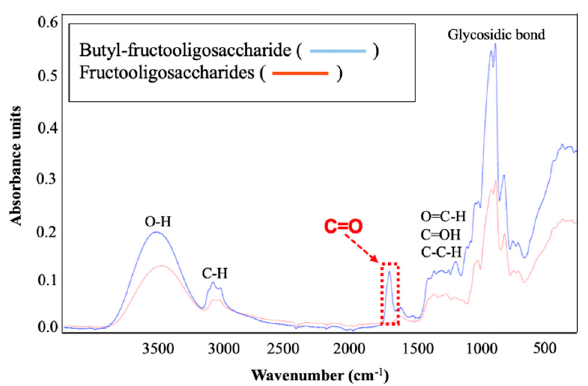
Figure 1. Absorbance spectra of butyl-fructooligosaccharides (B-FOS) and FOS by Fourier transform infrared (FT-IR) spectroscopy analysis. B-FOS (blue line); FOS (red line).